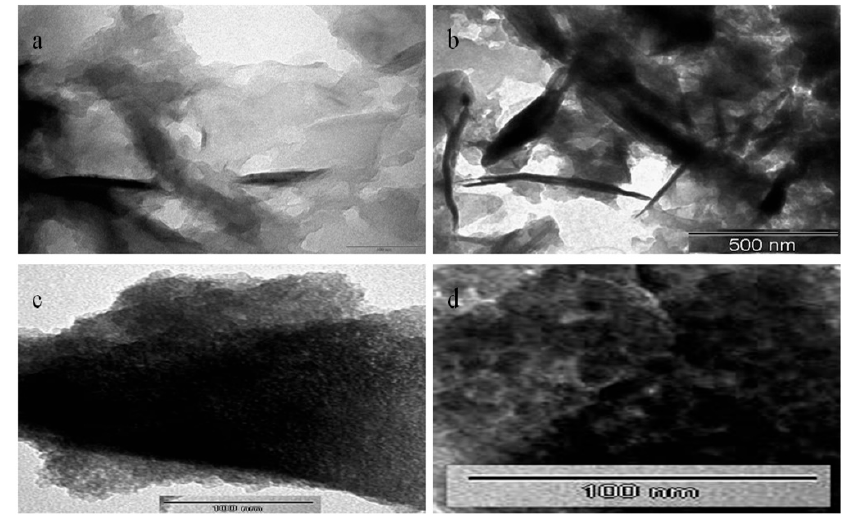
Figure 6. Transmission electron microscopy (TEM) images of ( a , b ) prepared graphene and ( c , d ) nanohybrid NH1.